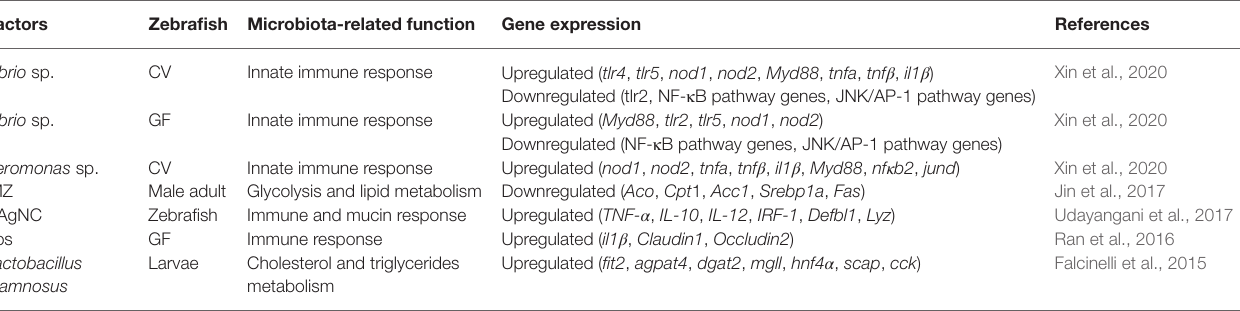
TABLE 2 | Factors affecting gene expression by affecting gut microbiota in zebrafish. Factors Zebrafish Microbiota-related